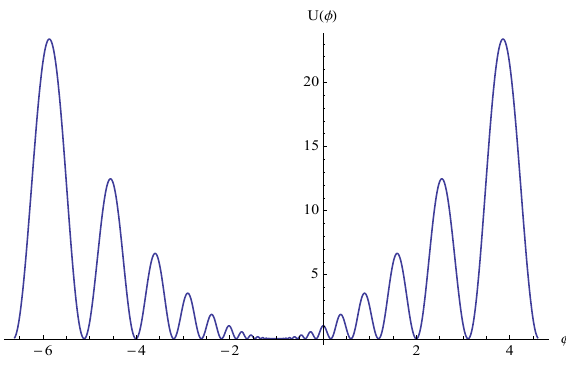
Figure 1 . Plot of the bosonic potential U ( (cid:30) ) for (cid:12) = 1 and B = 0 :